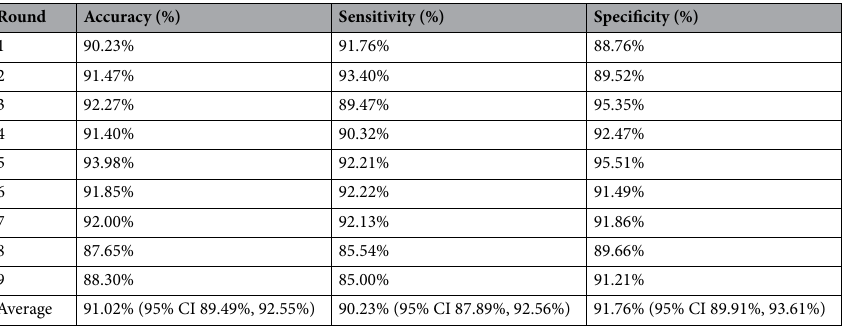
Table 3. The result of cross validation (benign vs. malignant).